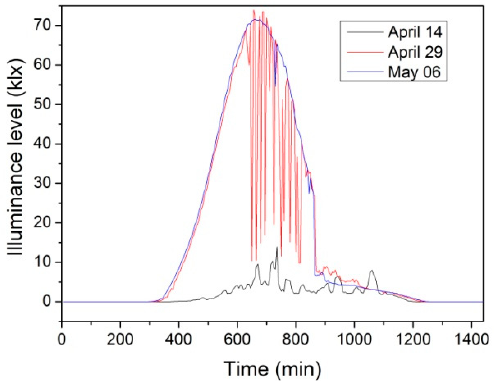
Figure 4. Various waveforms of daylight illuminance level measured by the weather station.